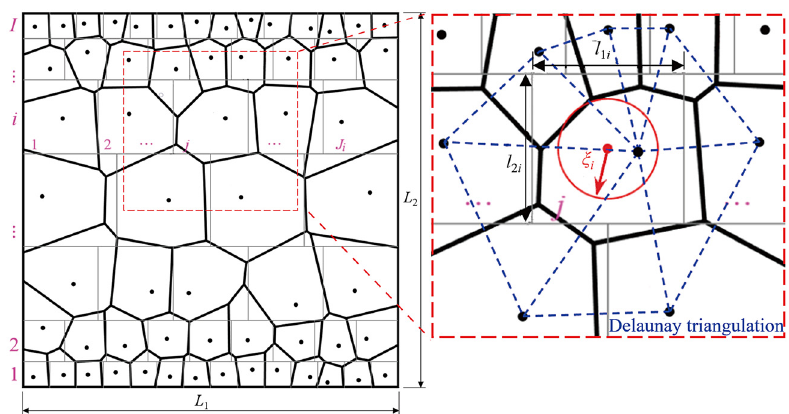
Figure 1: Schematic diagram of gradient Voronoi model generated by gradient grid and spreading circle methods. The length and height of the model are L 1 and L 2 , respectively; the thin solid lines and the thick solid lines represent cell edges and the grids, respectively, the dashed lines represent the Delaunay triangle network, and the dots represent the cell cores; the number of grid layers is I , J i , ξ i , l 1 i , and l 2 i represent the layer - cell - number, the radius of spreading circle, grid length, and height of the i th layer,